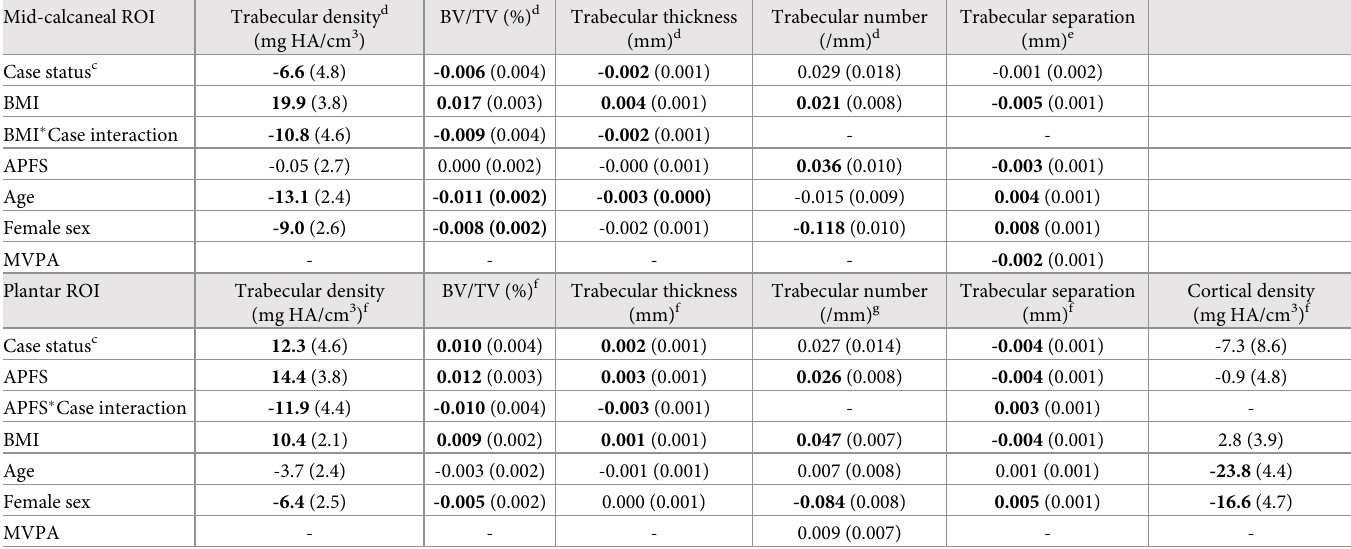
Table 4. Multivariable results for mid-calcaneal and plantar ROI, standardized co-efficients(se) a,b